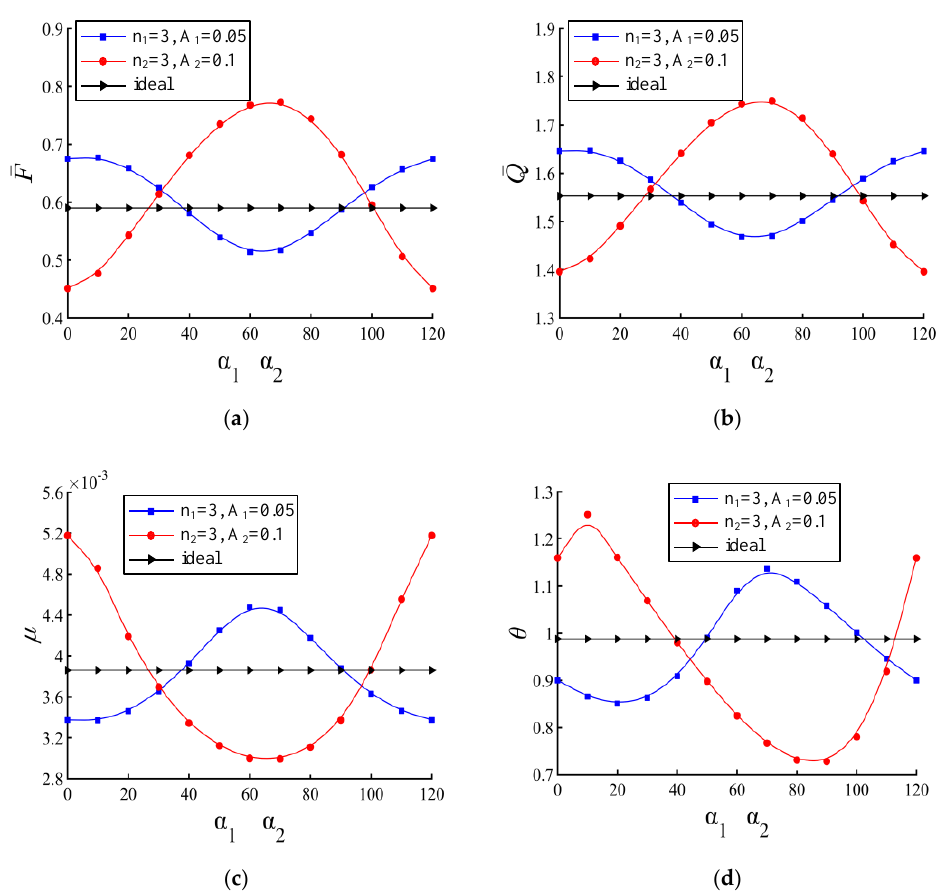
Figure 5. Variations of the dimensionless bearing load capacity ( a ), dimensionless end leakage flow rate ( b ), friction coefficient ( c ) and altitude angle ( d ) with phase angles of A 1 = 0.05, A 2 = 0.1 and n 1 = n 2 =